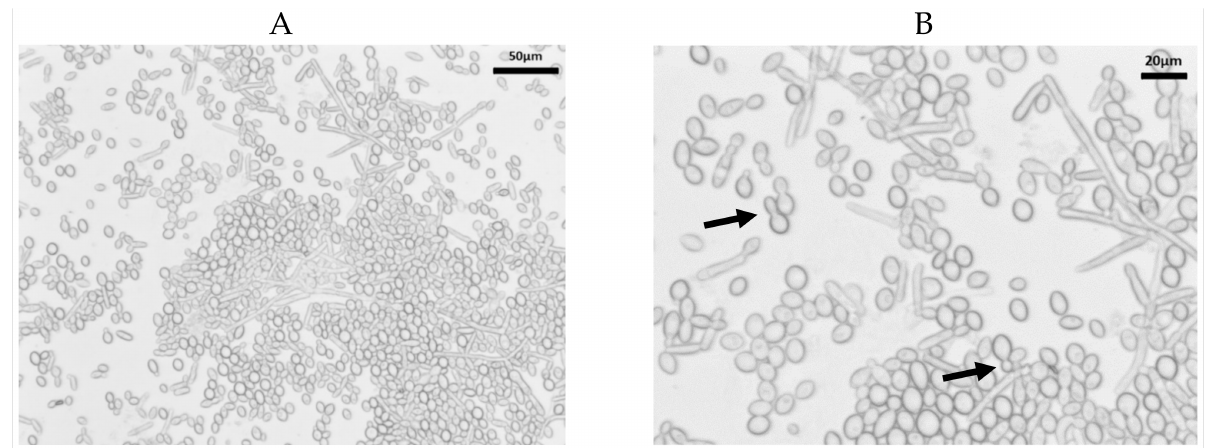
Figure 2. Microscopy of Kazachstania slooffiae . Polymorphic growth of K. slooffiae . K. slooffiae was grown in YPD + cef broth for 72 h and visualized by wet mount microscopy. ( A ) 20 × objective displaying yeast and hyphal growth. ( B ) A mixed culture with multiple pseudohyphae seen and budding yeasts (arrows).